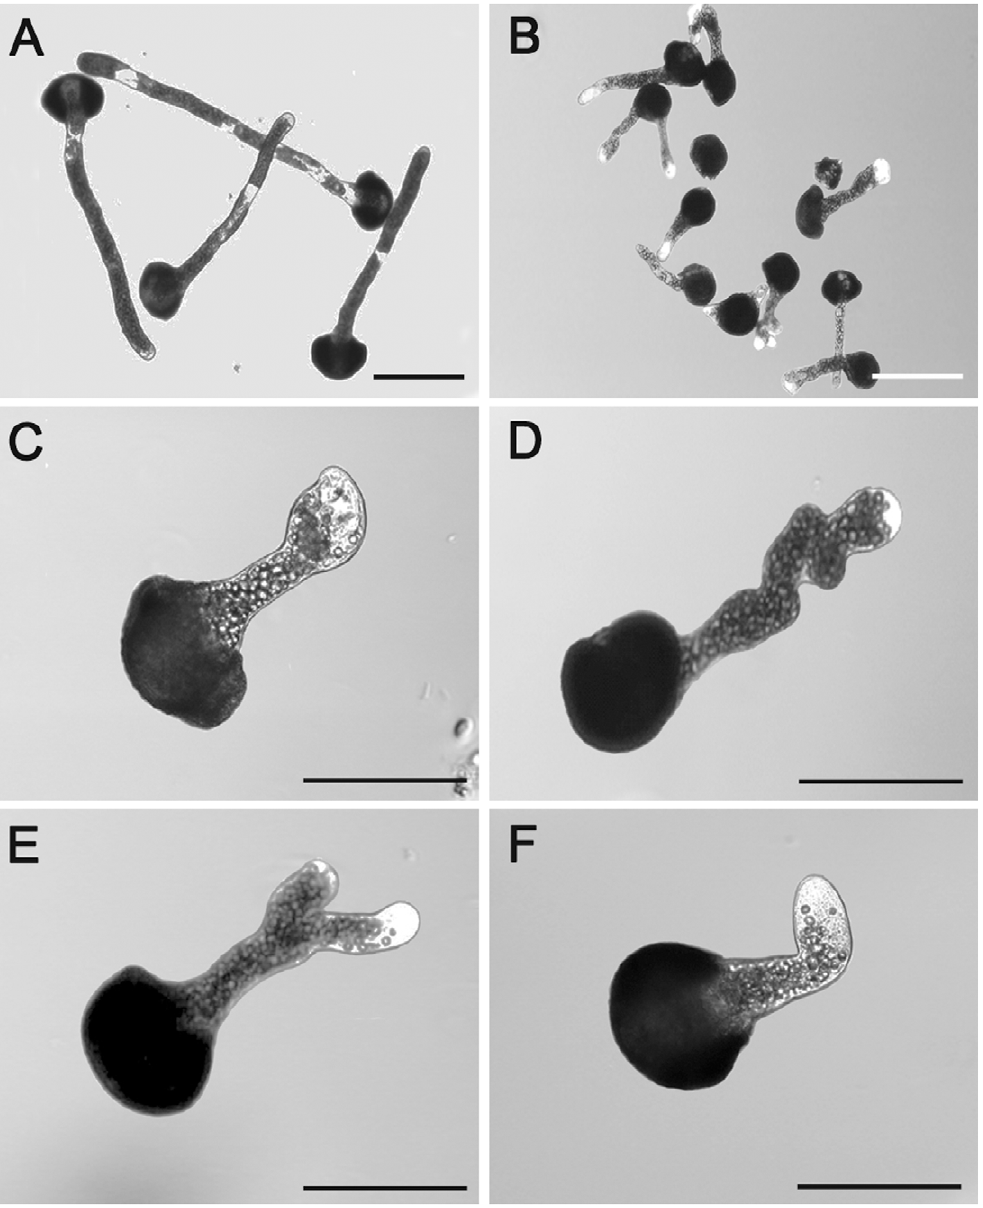
Figure 2. Abnormal morphology of Cedrusdeodara pollen tubes induced by 20 m M W7-agarose treatment. A, Untreated pollen tubes incubated in standard medium. B–F, Pollen tubes incubated with 20 m M W7-agarose. C, Tube with swollen tip. D: Twisted tube. E: Branched tube. F: Bent tube. A–B: Bar=200 m m; C–F: Bar=100 m m.